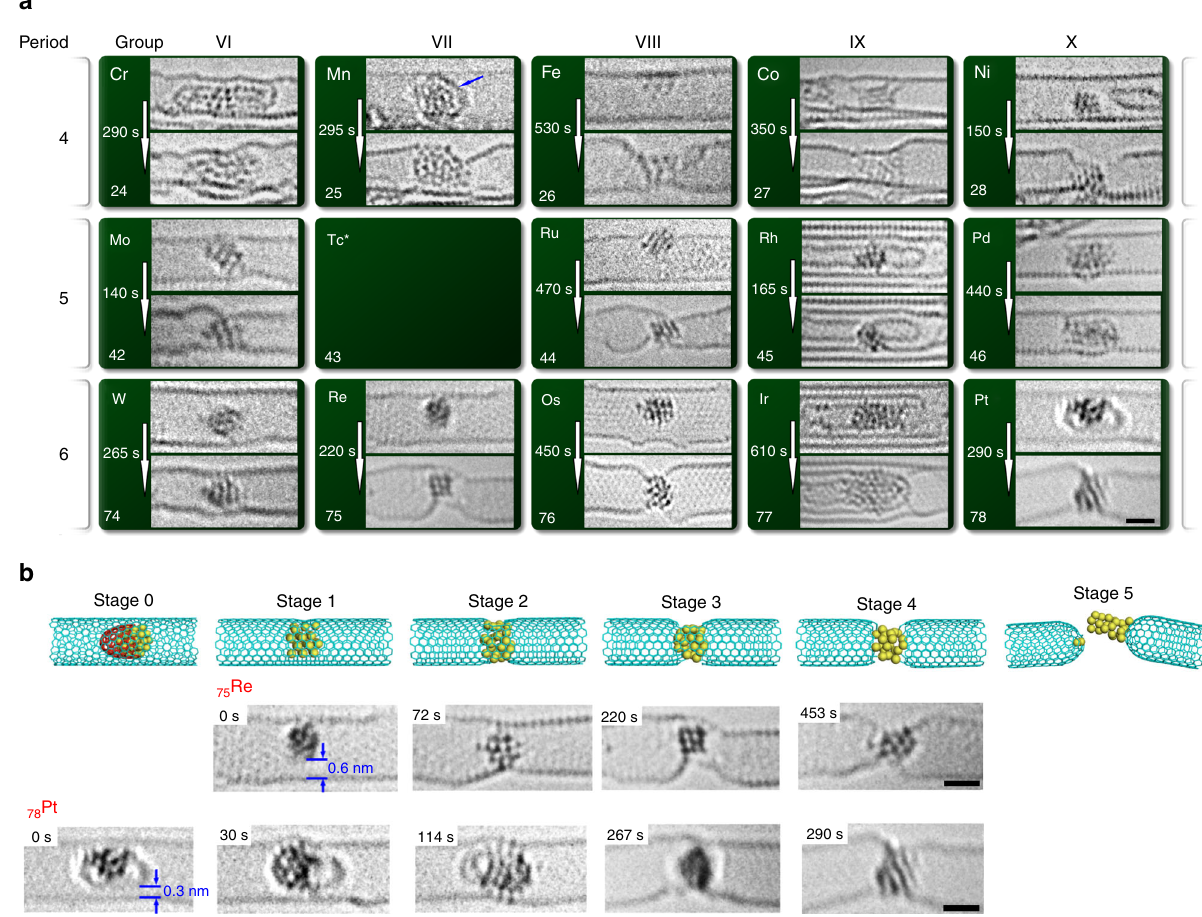
Fig. 3 Bonding of 14 metal nanoclusters with carbon. a Representative examples of 80 keV AC-HRTEM images of 14 transition metal nanoclusters in carbon nanotubes, highlighting their interactions and reactions with the carbon nanotubes. The carbon shell covering Mn which stabilises the Mn nanocluster against impact of the e-beam is marked by a blue arrow. b Schematic diagrams of the characteristic stages of defect formation and propagation in the host NT and time series AC-HRTEM images of Re and Pt, respectively, illustrating the evolution of the nanoclusters and NTs. The gap which is initially observed between the nanocluster and the bottom wall of the nanotube ( ≥ 0.3 nm) indicates that no covalent bonding is present between the metal and carbon along this direction at the start of the process, with the extent and rate of subsequent nanotube transformation related to the chemical nature of the metal. The scale bar is 1